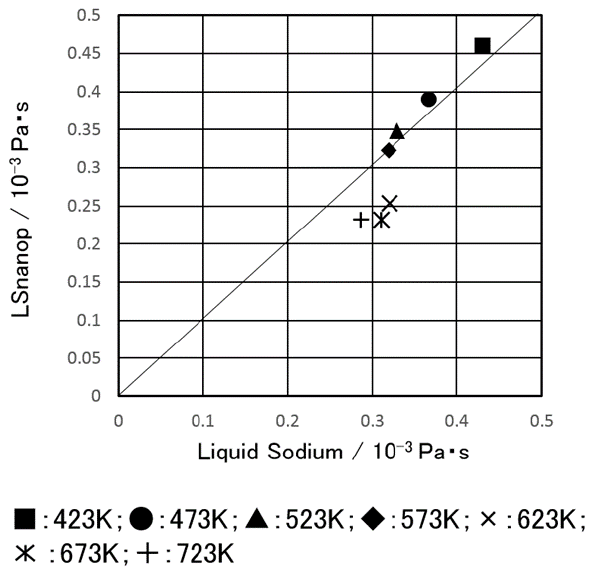
Figure 5. Comparison of the shear viscosities of LSnanop and liquid Na: The slanted line corresponds to the hypothetical case in which the viscosities of LSnanop and liquid Na are